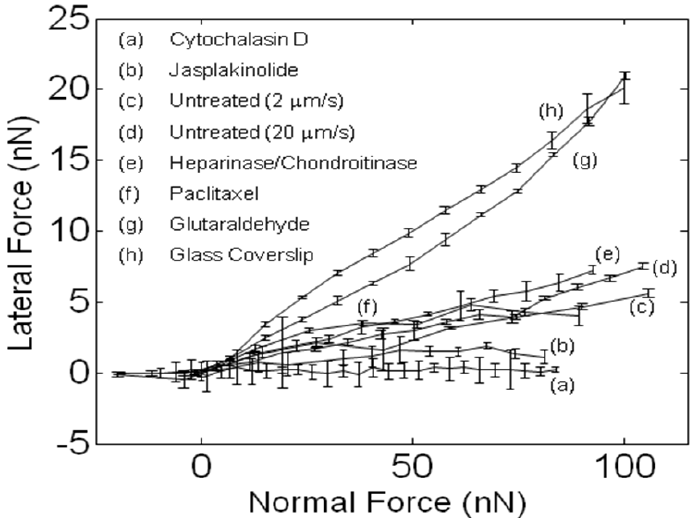
Figure 1. Representative frictional data (lateral force vs. normal force) from each VSMC group. Each curve corresponds to an individual cell chosen as a representative example due to its proximity to its respective VSMC group mean frictional coefficient. Each data point within a curve represents the mean ± SD for a particular normal force.